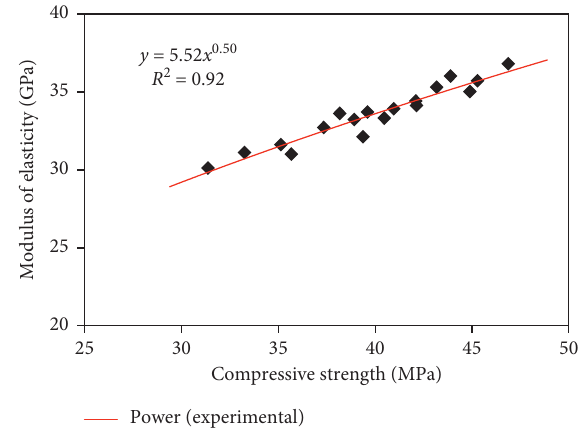
Figure 18: Correlation between modulus of elasticity and com- pressive strength of the mixes with RCA.